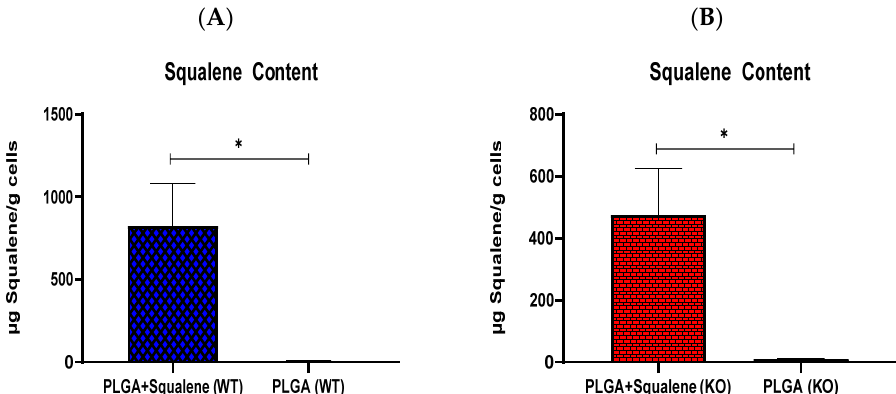
Figure 3. In vitro cellular uptake of squalene. Hepatic AML12 cells were incubated with 30 µM of PLGA-based squalene NPs and PLGA NPs for 72 h. ( A ) normal mouse AML12 cells (wild-type (WT)), ( B ) TXNDC5-deficient AML12 cells (knockout (KO)). Statistical analyses were done according to Mann–Whitney’s U-test; * p < 0.05.